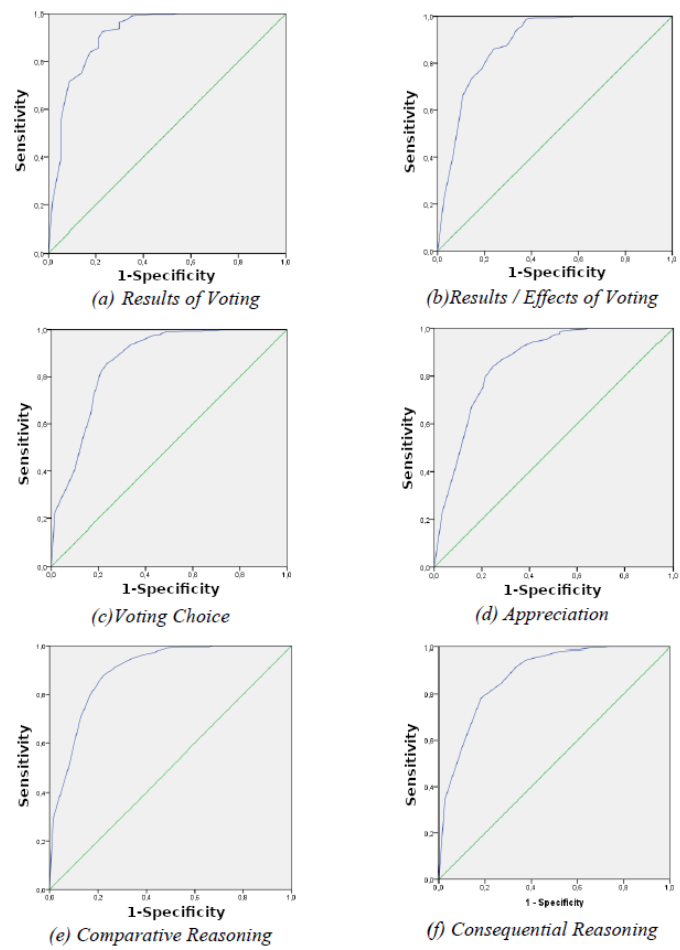
Figure 1. ROC curve analyses of the six sub-questions: ( a ) nature of voting, ( b ) results/effects of voting, ( c ) voting choice, ( d ) appreciation, ( e ) comparative reasoning, ( f ) consequential reasoning.